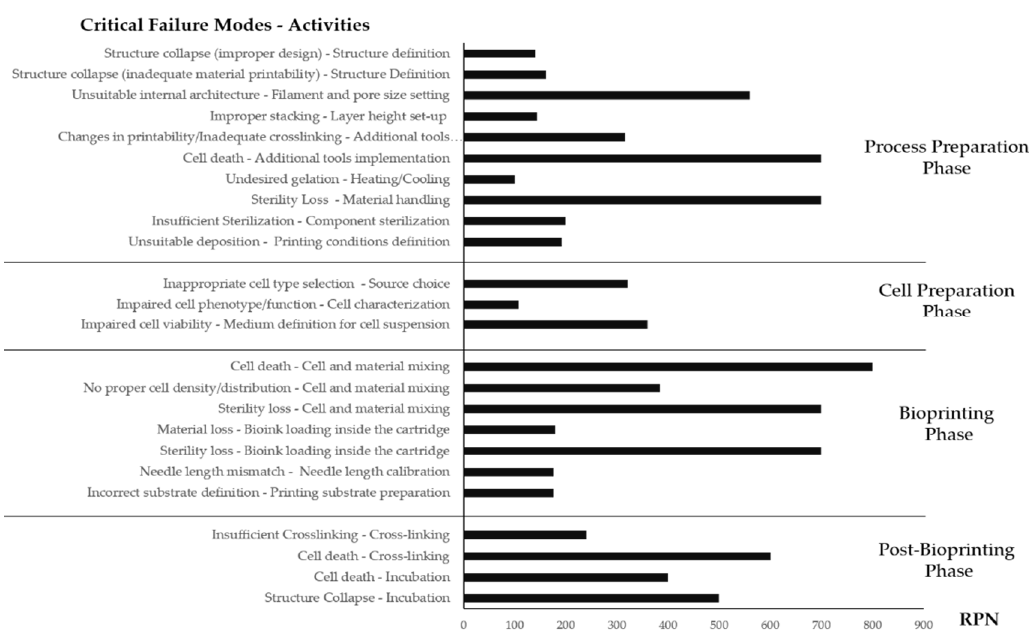
Figure 4. Schematic representation of critical (RPN > 100) failure modes and their related activities together with the established RPN